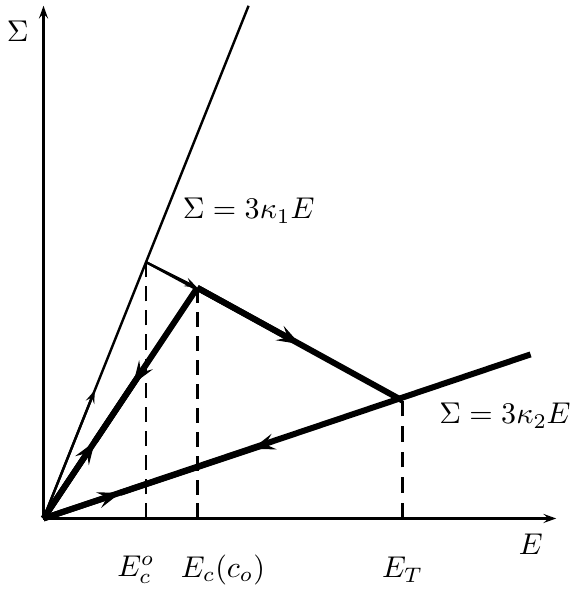
Figure 2 . The response of the composite sphere with local